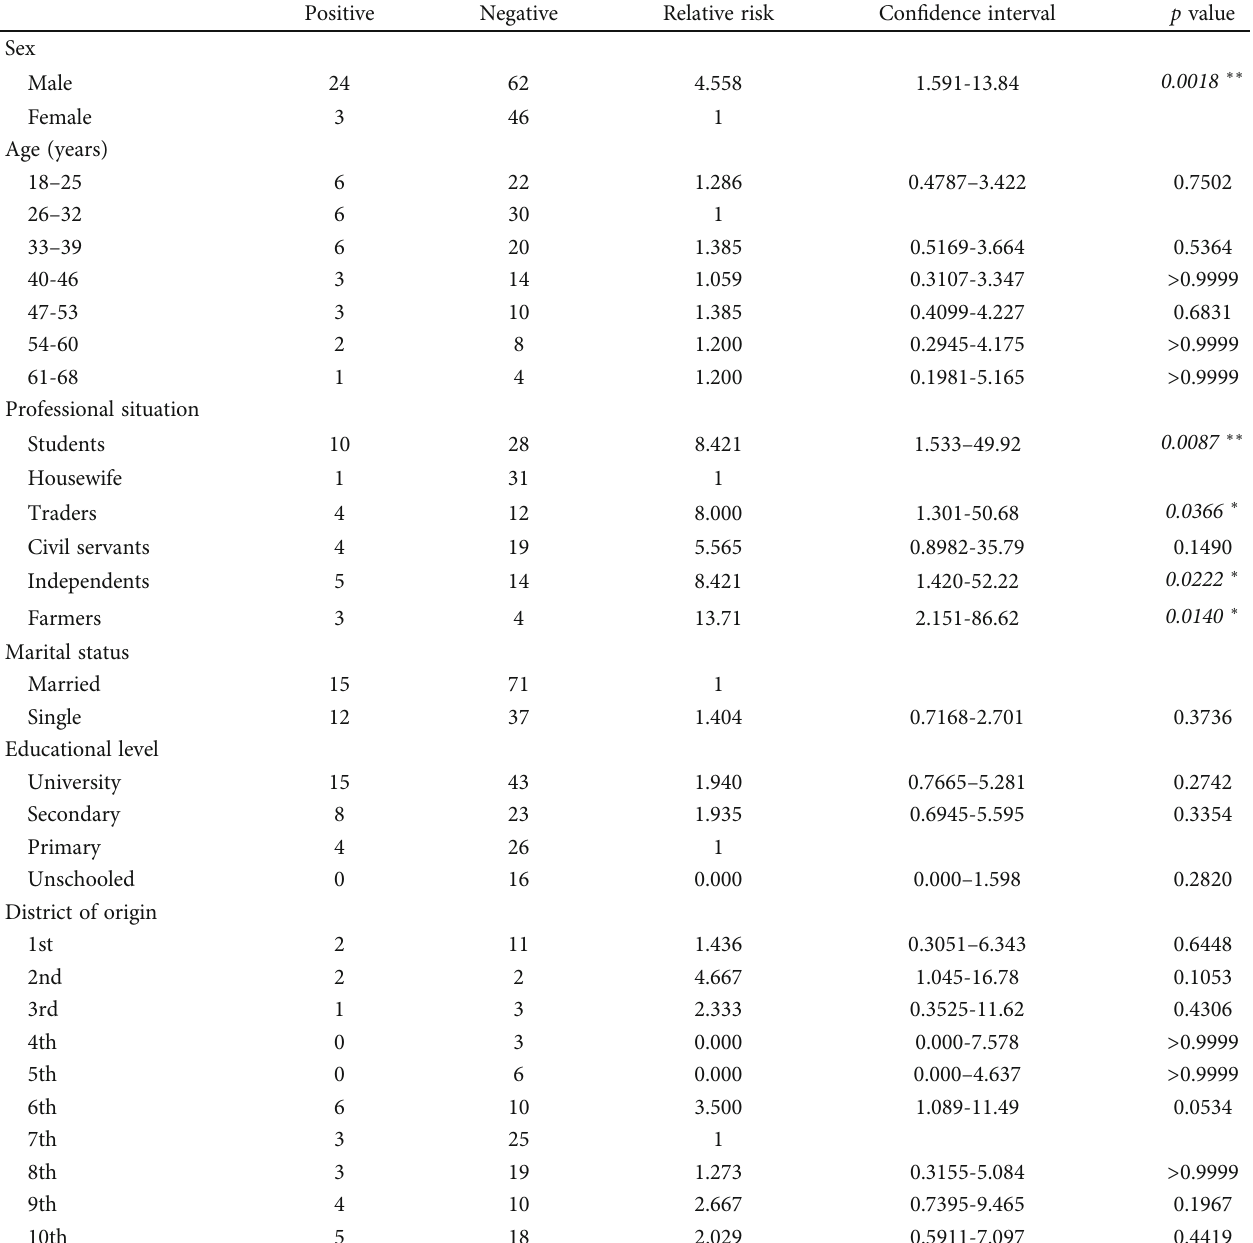
Table 3: E ff ect of sociodemographic factors on HEV